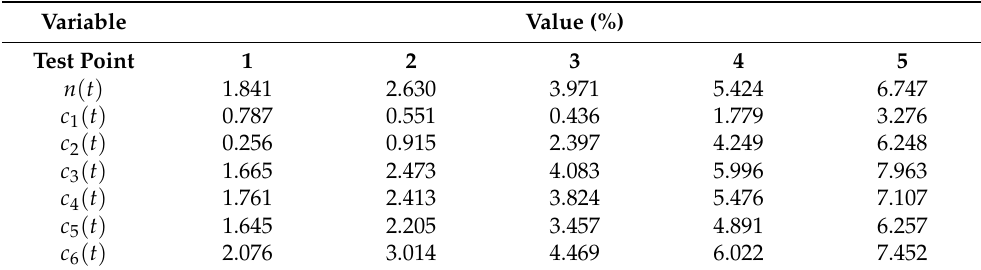
Table 6. Case 3. Percentage error of extrapolation of the training data in time interval t ∈ [ 0, 202 ] s using five testing points in time interval t ∈ [ 203, 217 ] s